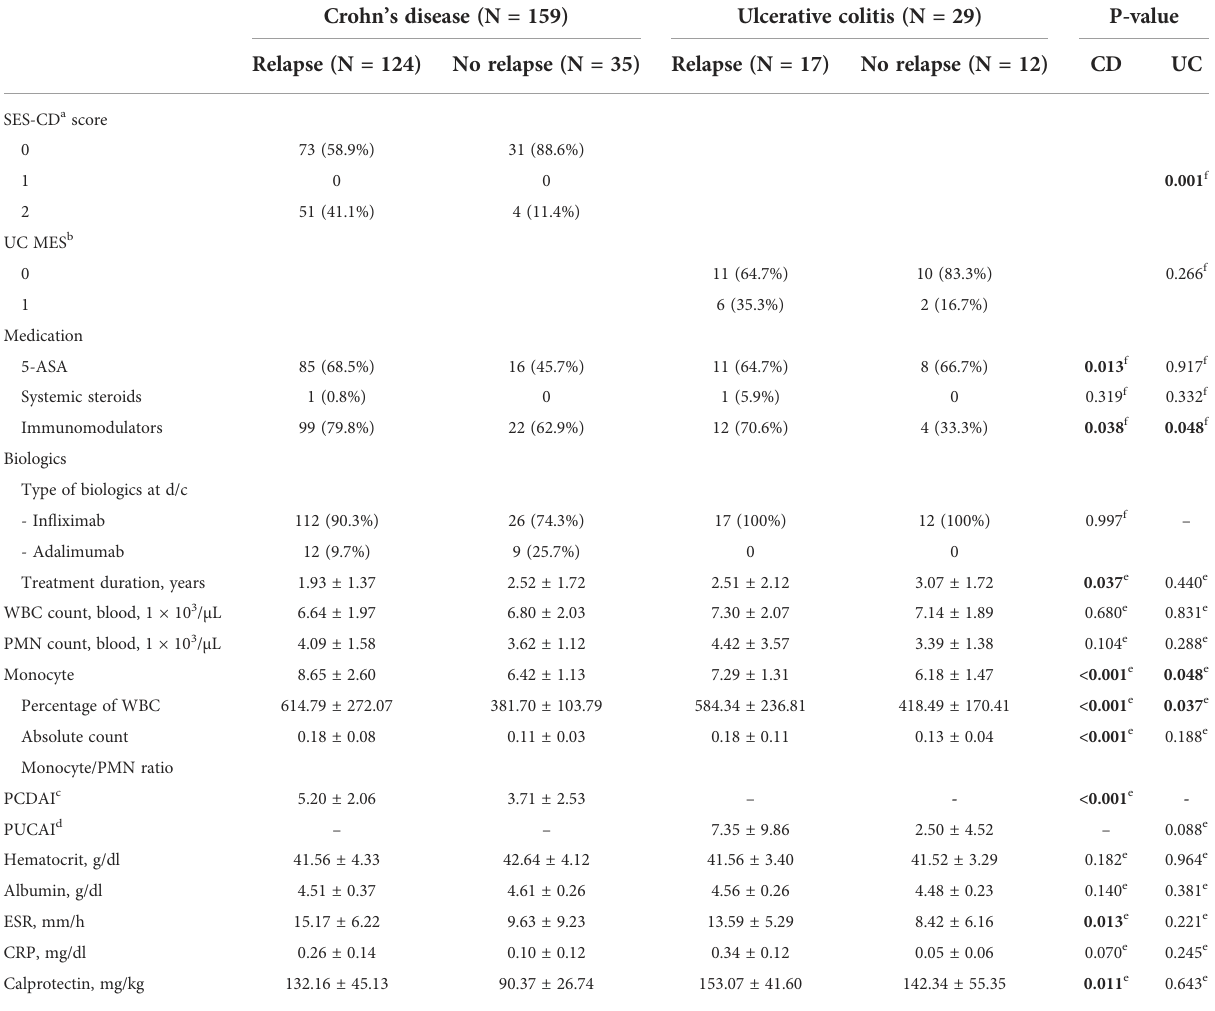
TABLE 2 Clinical features and monocyte count at discontinuation of biologic agents of the two experimental groups: patients who experienced relapse and patients who did not experience relapse after biologic discontinuation. Crohn ’ s disease (N =